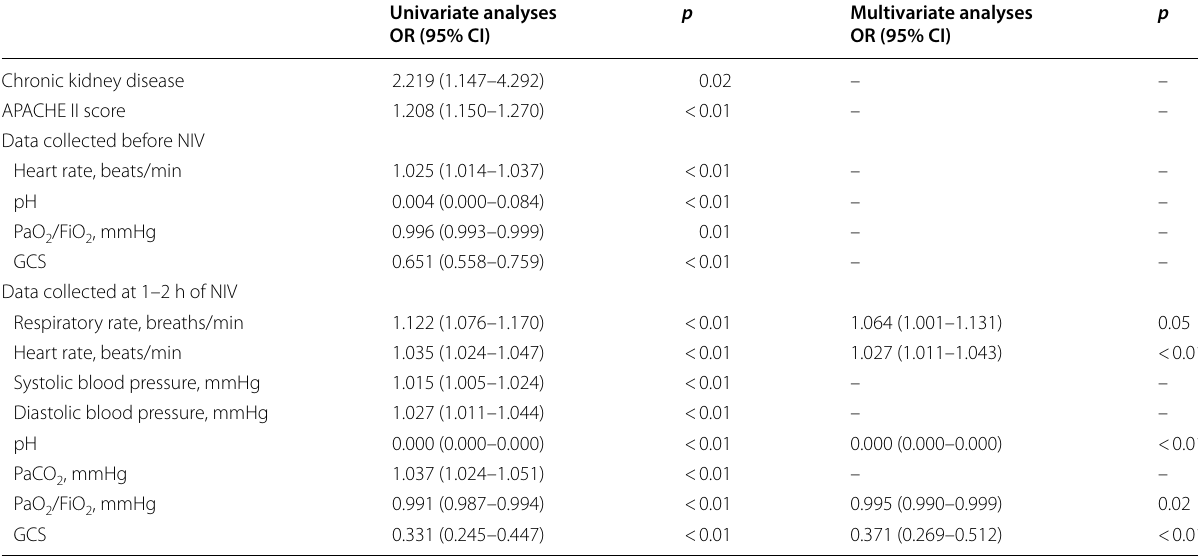
NIV noninvasive ventilation, OR odds ratio, CI confidence interval, GCS Glasgow coma scale